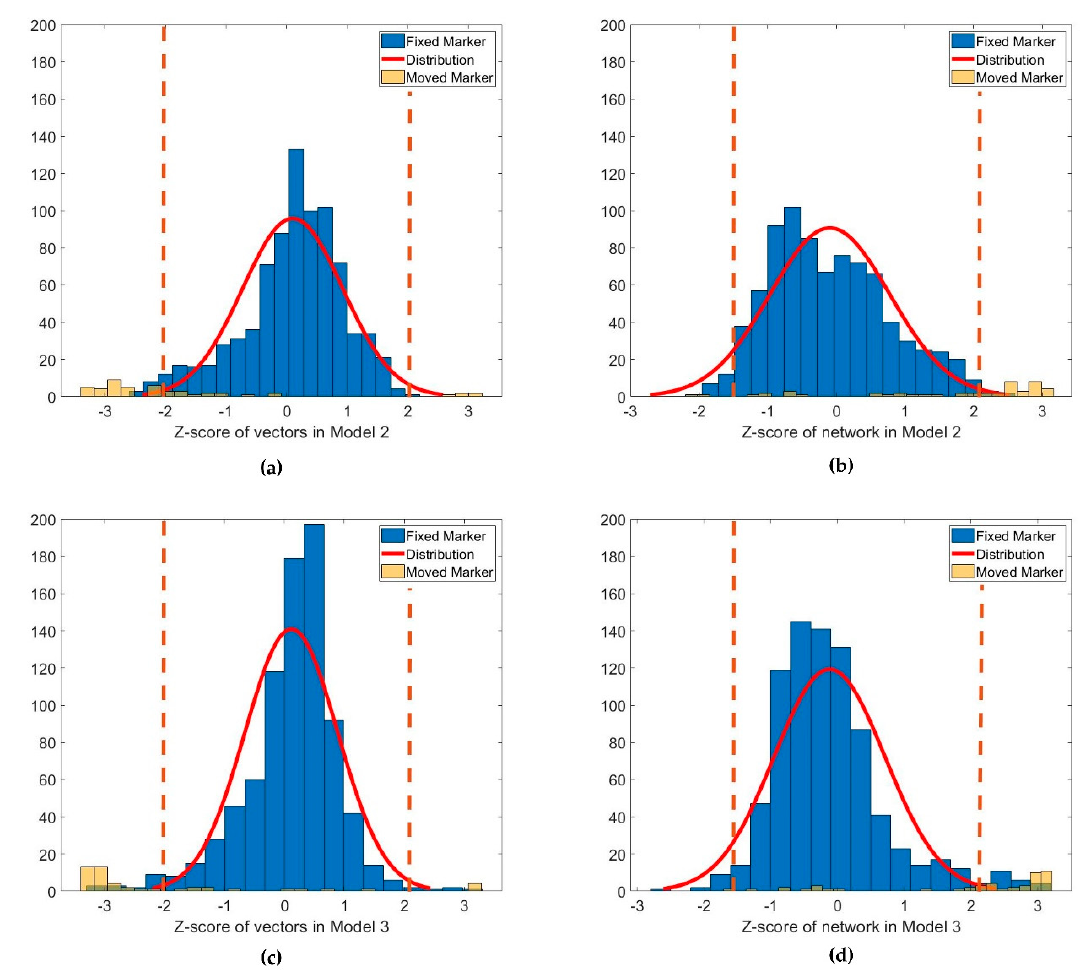
Figure 11. Z-scores of each method in Models 2 and 3: ( a ) Z-score of marker vectors in Model 2; ( b ) Z-score of network length in Model 2; ( c ) Z-score of marker vectors in Model 3; ( d ) Z-score of network length in Model 3. Table 7. Anomaly detection performance by